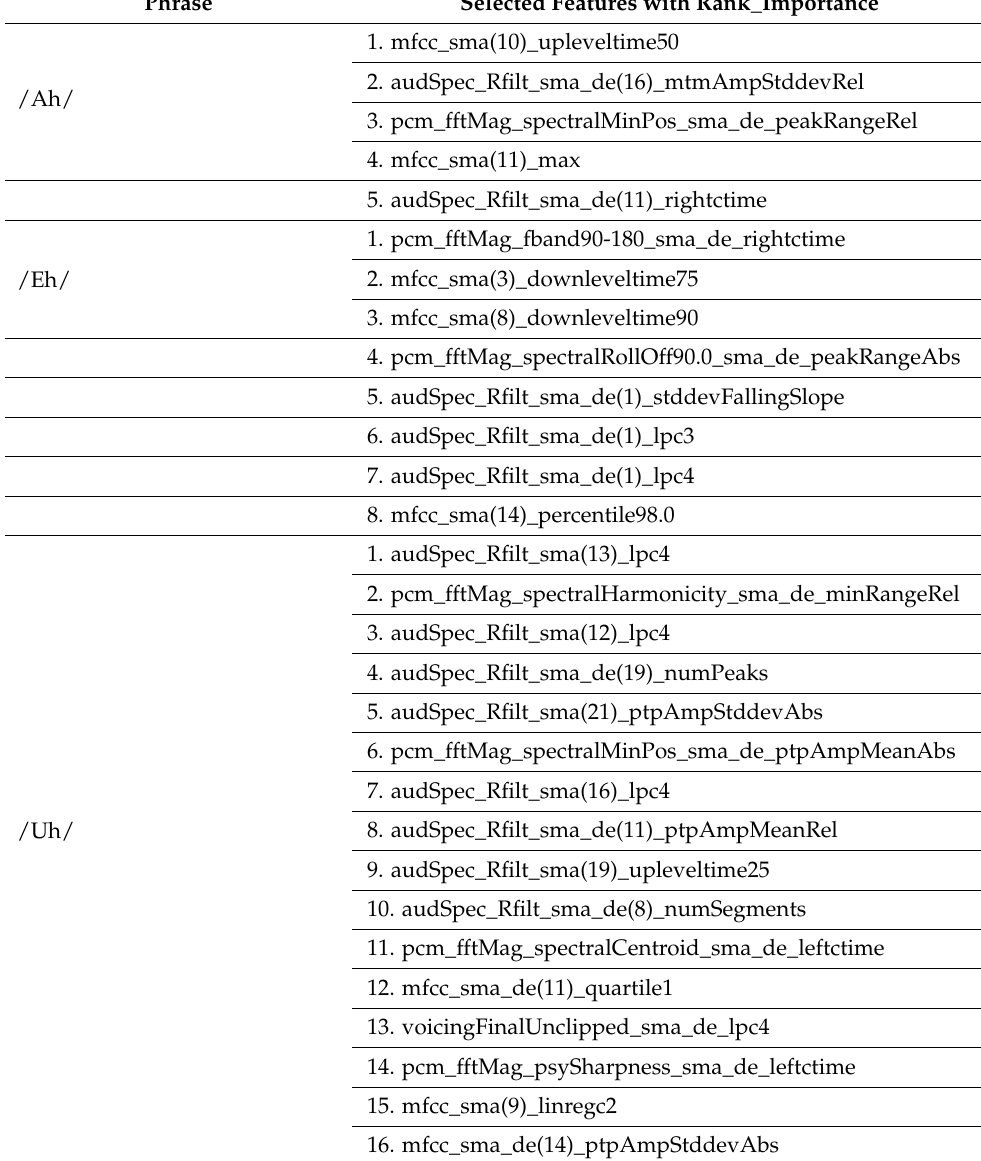
Table 8. Selected